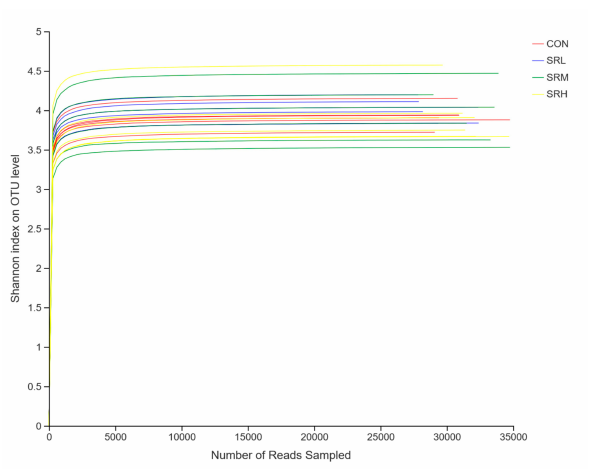
Figure 4. Shannon index dilution curve.